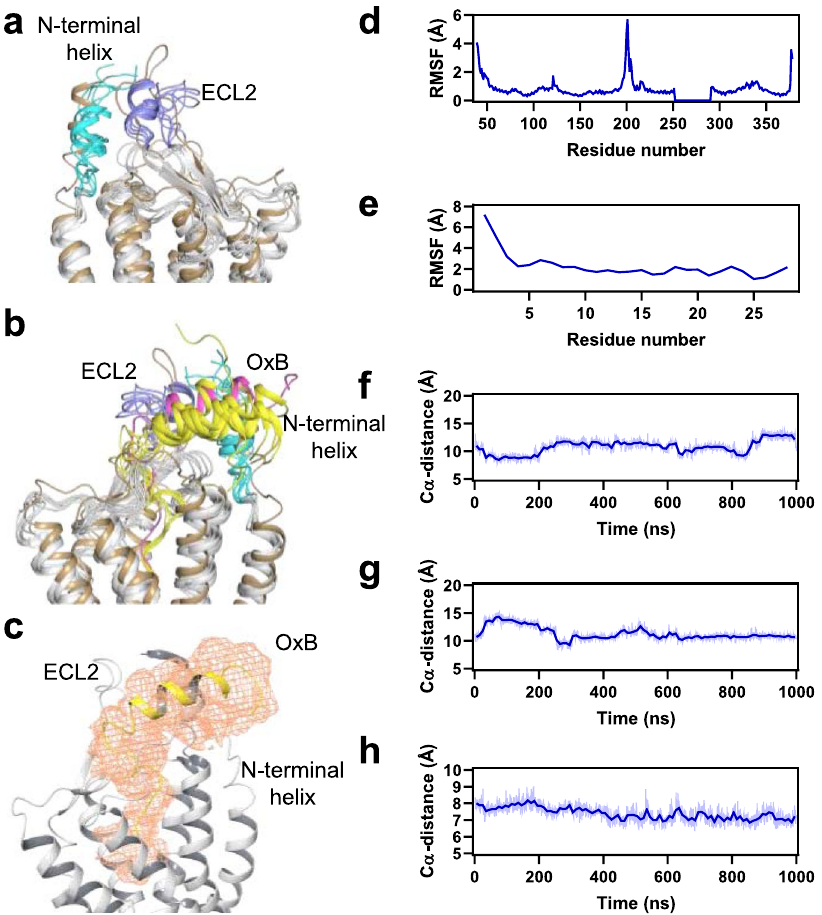
Fig. 4 Molecular dynamics simulations. a , b Representative frames from a 1000-ns MD trajectory overlaid with the model of OX 2 R bound to full-length OxB (sand). OX 2 R and OxB ensembles from the simulation are colored gray and yellow, respectively. The amino-terminal α -helix and ECL2 of OX 2 R are highlighted in cyan and light blue, respectively. Note, in a , OxB was omitted for clarity. c MD-derived density map (orange mesh) of OxB de fi ning the space occupied by the peptide during the simulations, showing that the amino-terminal portion of OxB remains α -helical, but is more fl exible than the extended carboxy-terminal portion buried in the OX 2 R core. d , e Root mean square fl uctuation (RMSF) values of α -carbons of OX 2 R and OxB, respectively, during a representative simulation. f – h Distances between α -carbons of pairs of residues in OxB and OX 2 R monitored over the course of the same representative simulation. Residue pairs are: Q12(OxB) – F197 (ECL2 of OX 2 R), Q12(OxB) – E46 (amino-terminal helix of OX 2 R), and I25(OxB) – F346 7.35 (core of OX 2 R), respectively. A central moving average (window length: 10 ns) of the α -carbon distance for each pair is indicated by a dark blue line. Source data are provided as a Source Data fi